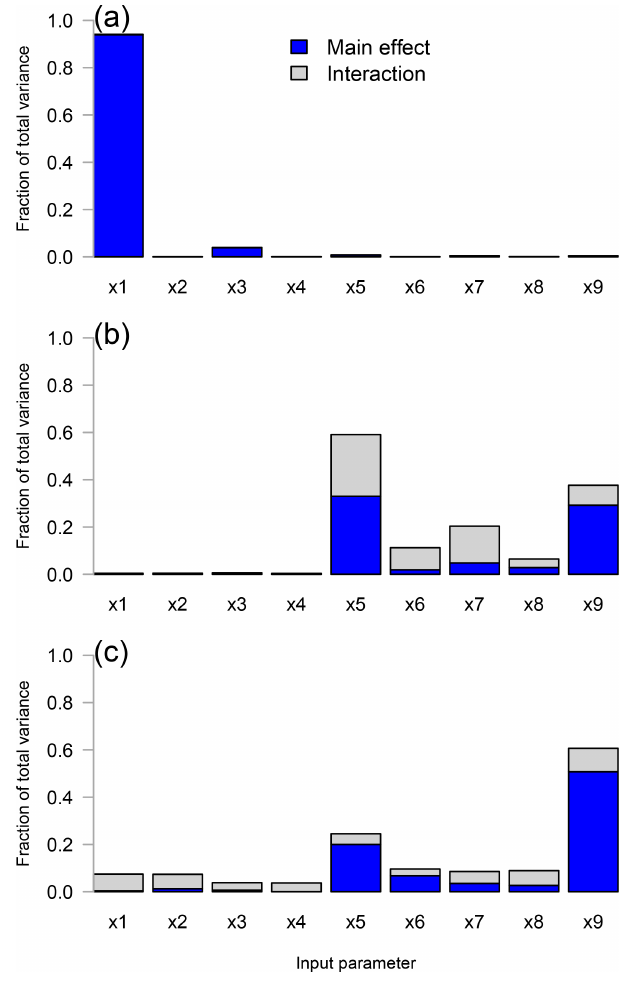
Figure 4. Fraction of total variance explained by each input param- eter, for (a) AOD, (b) SS, and (c) λ . The light gray portion of each bar represents the contribution of interaction terms, while the blue portion represents the main effect. The full height of each bar rep- resents the total variance explained by each input parameter, with more influential parameters explaining a higher fraction of